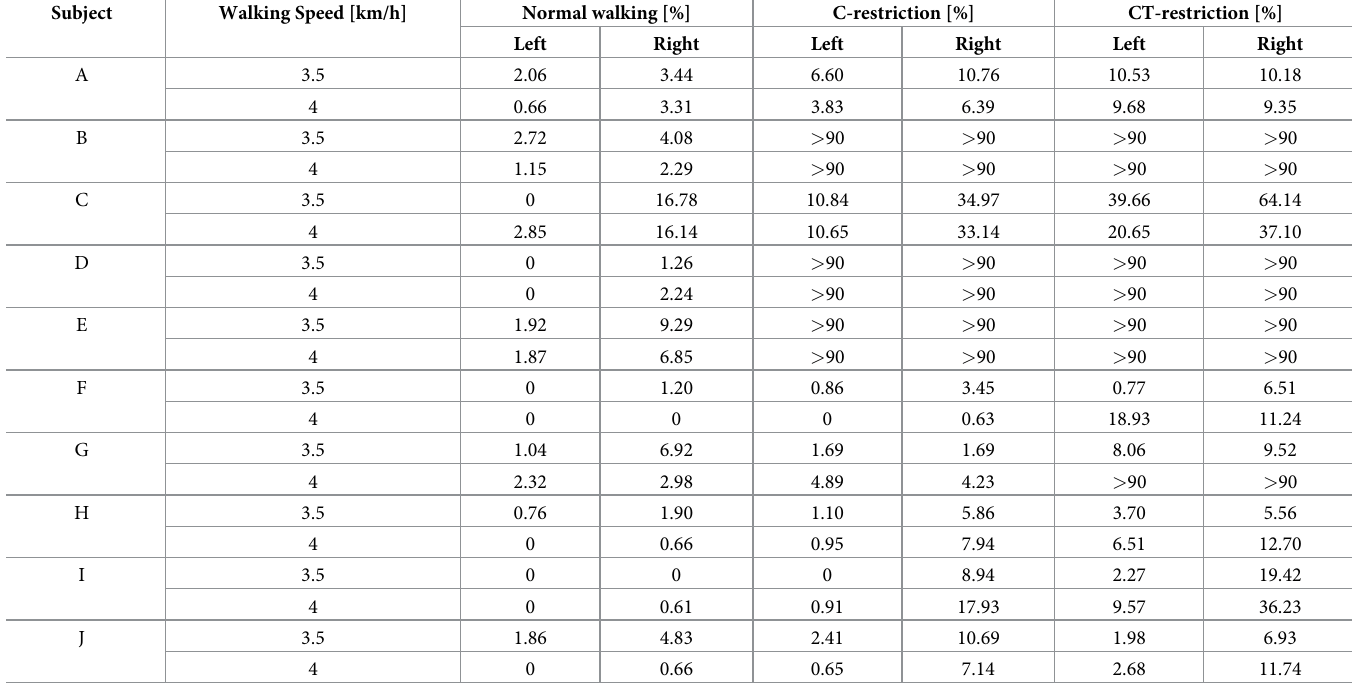
The number of contacts is expressed as a percentage of the total gait